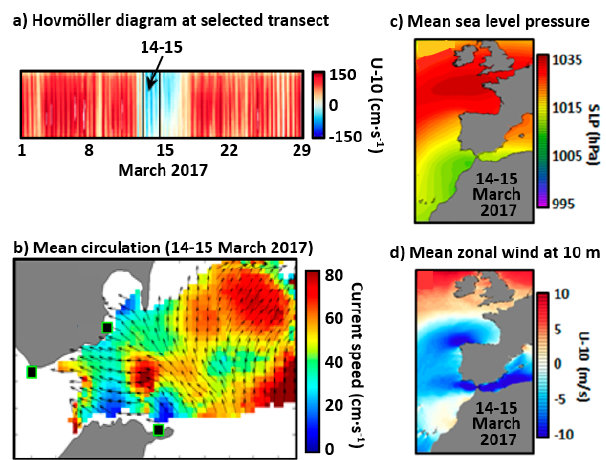
Figure 8. (a) Monthly Hovmöller diagram of HFR-derived zonal current speed at the selected transect (shown in Fig. 4a). Red (blue) represents eastward (westward) surface flow. A 2d episode of per- manent flow reversal is marked (14–15 March). (b) HFR-derived mean surface circulation for 14–15 March 2017: permanent flow reversal. (c–d) 2d mean sea level pressure and zonal wind at 10m height ( u 10 ), respectively, as provided by the ECMWF: intense and persistent easterlies were the driver of the flow reversal. Original source: from Lorente et al.